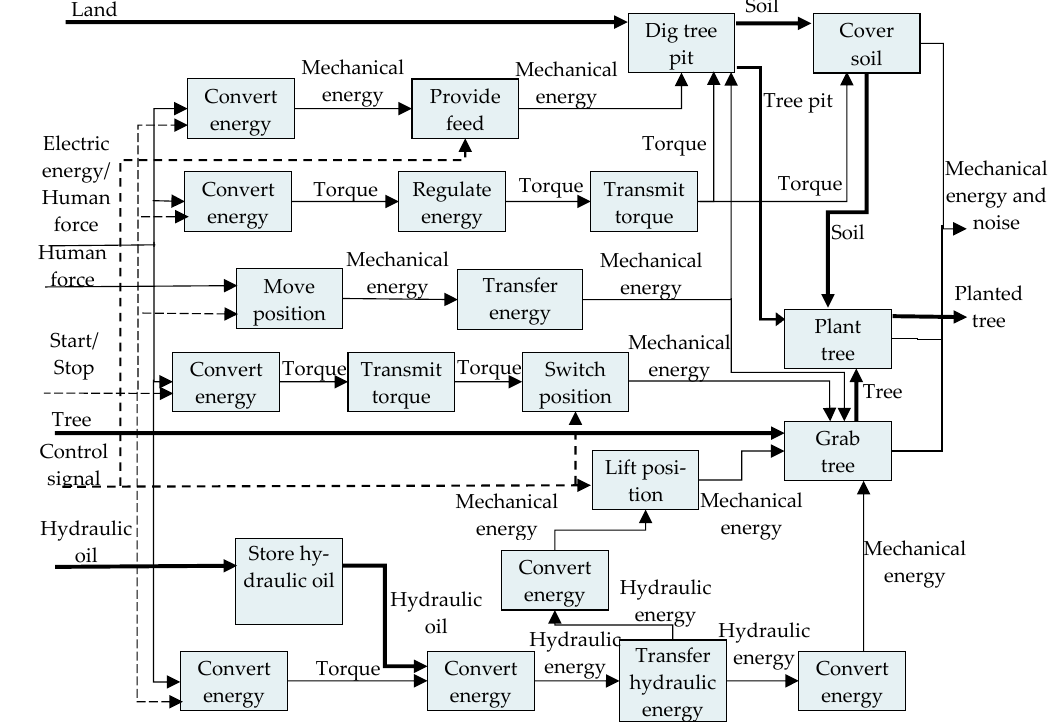
Figure 31. New tree-planting machine functional structure.